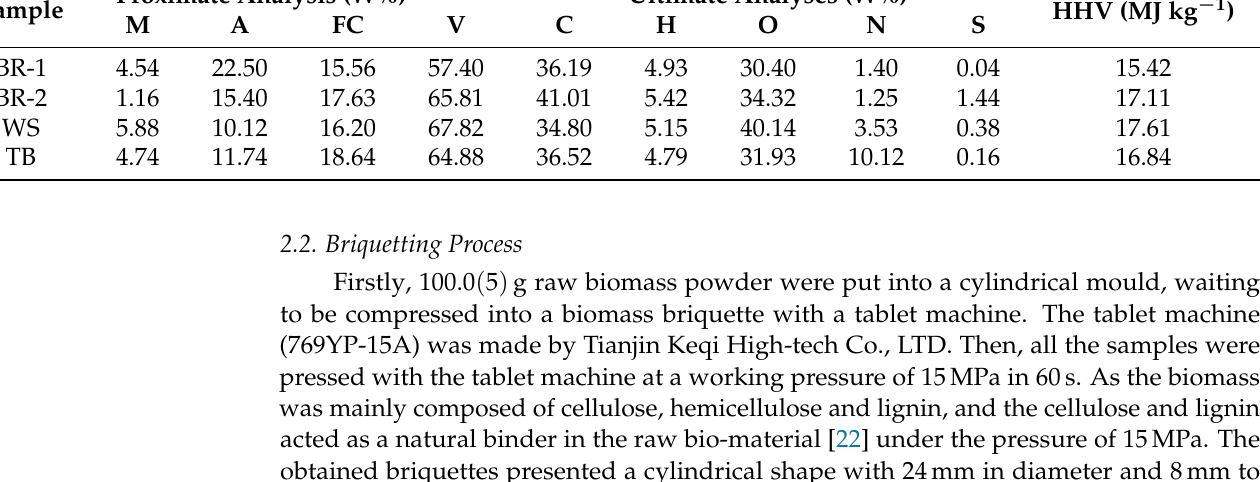
Table 1. Ultimate, proximate analysis and Higher Heating Value (HHV) of the biomass samples.